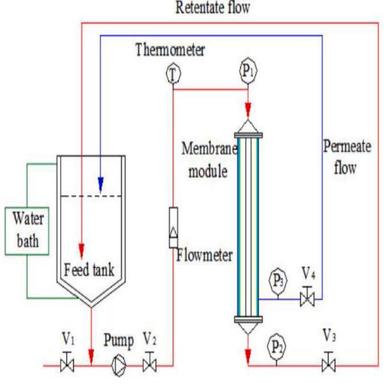
Experimental device for dynamic membrane fabrication and crossflow filtration.